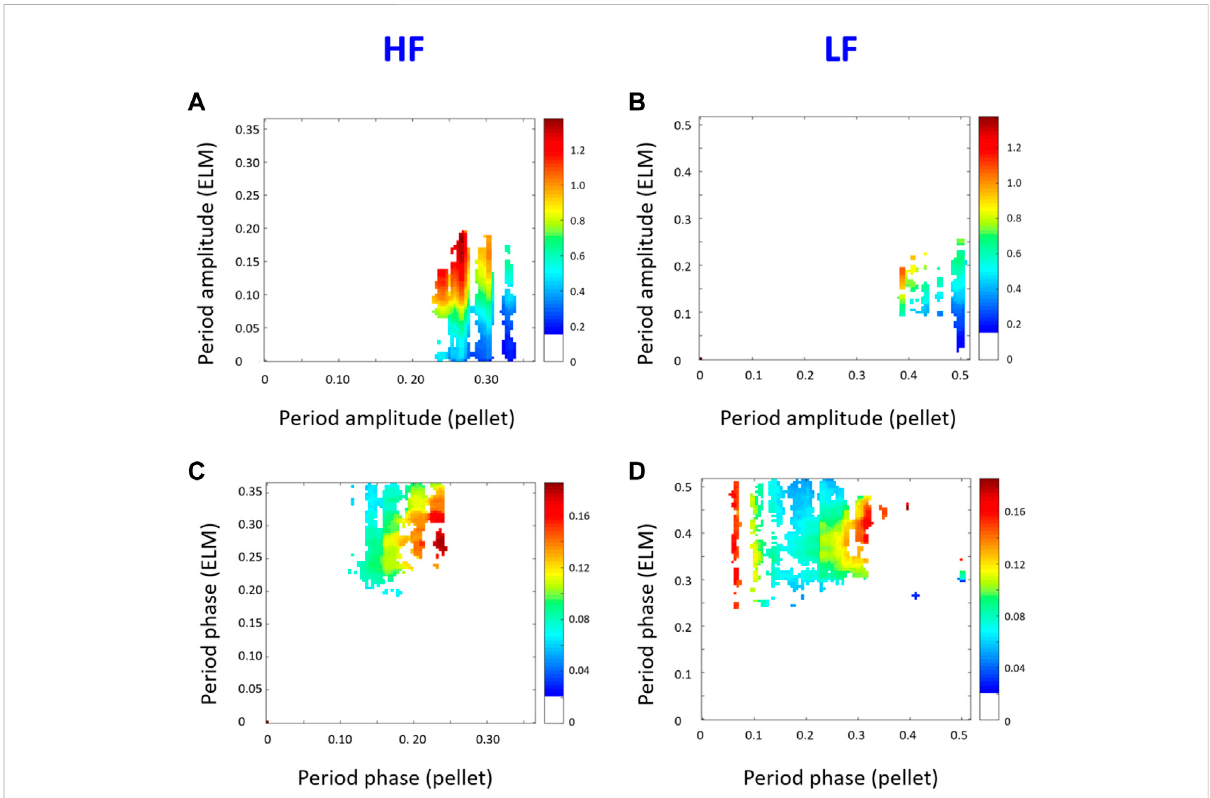
FIGURE 13 CMI plots patterns showing causal interactions between pellets and ELMs time series for AUG pulse #34462, for the time interval 5.2-5.5s: phase-phase (A) , amplitude-phase (B) , amplitude-amplitude (C) and phase-amplitude (D) . Amplitude-amplitude causal interactions are the dominanteffectbutthephase-phaseinteractionsareofthesameorderofmagnitude.Thecolourcoderepresentsthelevelofcouplingderivedwith theconditionalmutualinformationCMI.Periodsaremeasuredinseconds.The fi guresdisplaythepositivesigni fi cance-leveldeviationsfromthe 99th percentile of the average CMI calculated using 50 Fourier transform